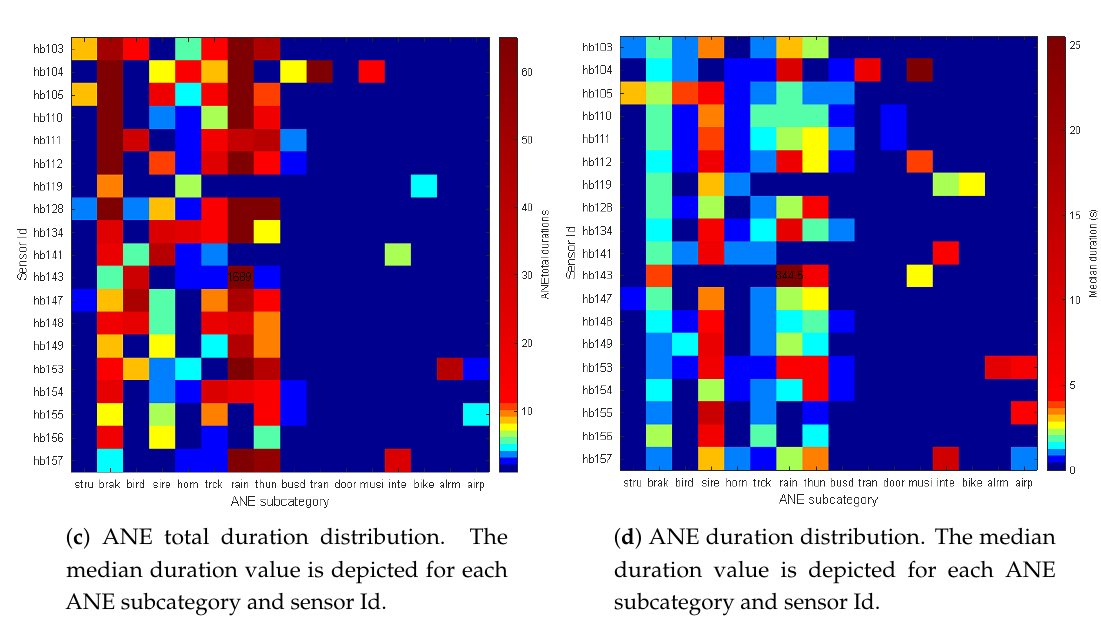
Figure 9. ANE parameters distribution per subcategory for each WASN